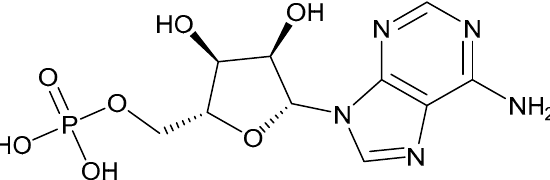
Figure 1. Chemical structure of adenosine monophosphate (AMP).